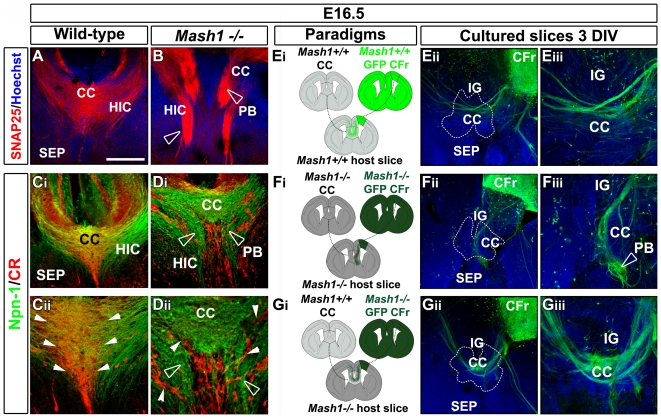
CC neuronal network integrity is important for pathfinding by callosal axons.(A–D) Single immunohistochemistry for SNAP25 (A and B) and double immunohistochemistry for Npn-1 and CR (Ci–Cii and Di–Dii) in coronal CC sections from E16.5 WT (A, Ci, and Cii) and Mash1−/− (B, Di, and Dii) mice. (Cii and Dii) are higher power views of the medial CC seen in (Ci and Di). (A, Ci, and Cii) At E16.5, both callosal and hippocampal commissure (HIC) fibers labeled with SNAP25 or Npn-1 begin to cross the midline and grow towards the contralateral cortex. (B, Di, and Dii) By contrast, in Mash1−/− brains, the majority of callosal and hippocampal fibers do not cross the midline and form large ectopic bundles of axons on either side of it, reminiscent of Probst bundles (PB; open arrowheads). (Di and Dii) The loss of Mash1-positive GABAergic interneurons of the CC causes the disorganization of glutamatergic CR+ neurons at the midline (compare [Dii] with [Cii], arrowheads). (Ei) Experimental paradigm used to confirm the growth of E16.5 GFP+ WT callosal axons in CC transplants and slices from WT mice. (Eii–Eiii) GFP immunocytochemistry showing that WT GFP+ callosal axons grow normally and cross the midline when they are confronted with a WT environment. (Fi) Experimental paradigm used to confirm the growth defects of E16.5 GFP+
Mash1 mutant callosal axons in CC transplants and slices from Mash1−/− mice. (Fii–Fiii) GFP immunocytochemistry showing that GFP+ callosal axons of Mash1−/− cortical explants do not cross the midline, but rather form Probst bundles (PB, open arrowhead). (Gi) Experimental paradigm used to test whether the CC neuronal network integrity is necessary and sufficient to direct the growth of callosal axons. To this end, WT CC is transplanted in a Mash1−/− slice. (Gii–Giii) GFP immunocytochemistry showing the complete restoral of Mash1−/− callosal axons pathfinding. Dashed lines outline the CC transplant localizations. Brain slices in (Eii–Eiii, Fii–Fiii, and Gii–Giii) were counterstained with Hoechst. Bar indicates 435 µm in (Eii, Fii, and Gii), 220 µm in (A, B, Ci, Di, Eiii, Fiii, and Giii), and 110 µm in (Cii and Dii). CFr, frontal cortex.